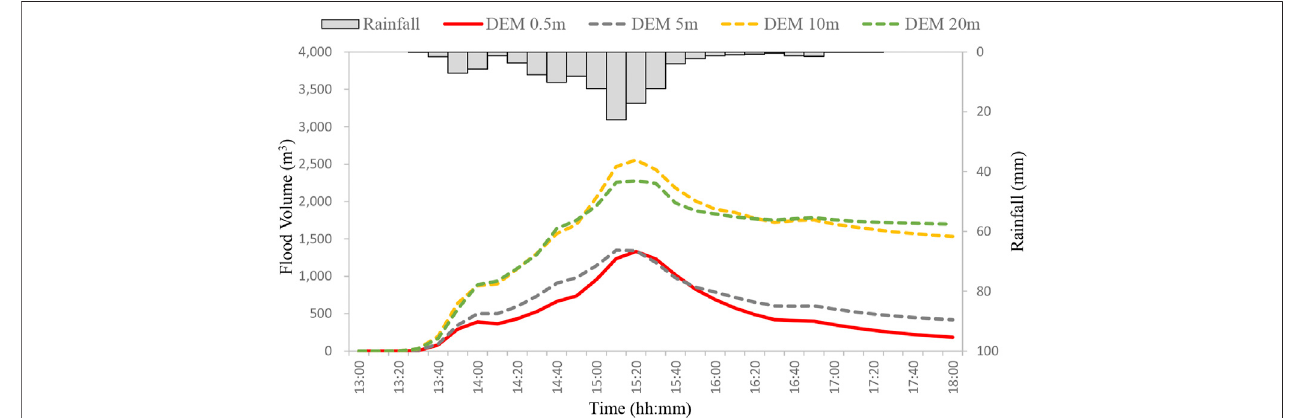
FIGURE 9 | Comparison of simulated fl ood volume under four DEM resolutions.